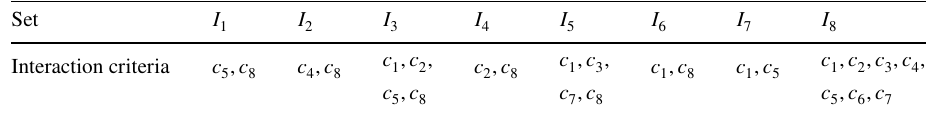
interaction I j with respect to C